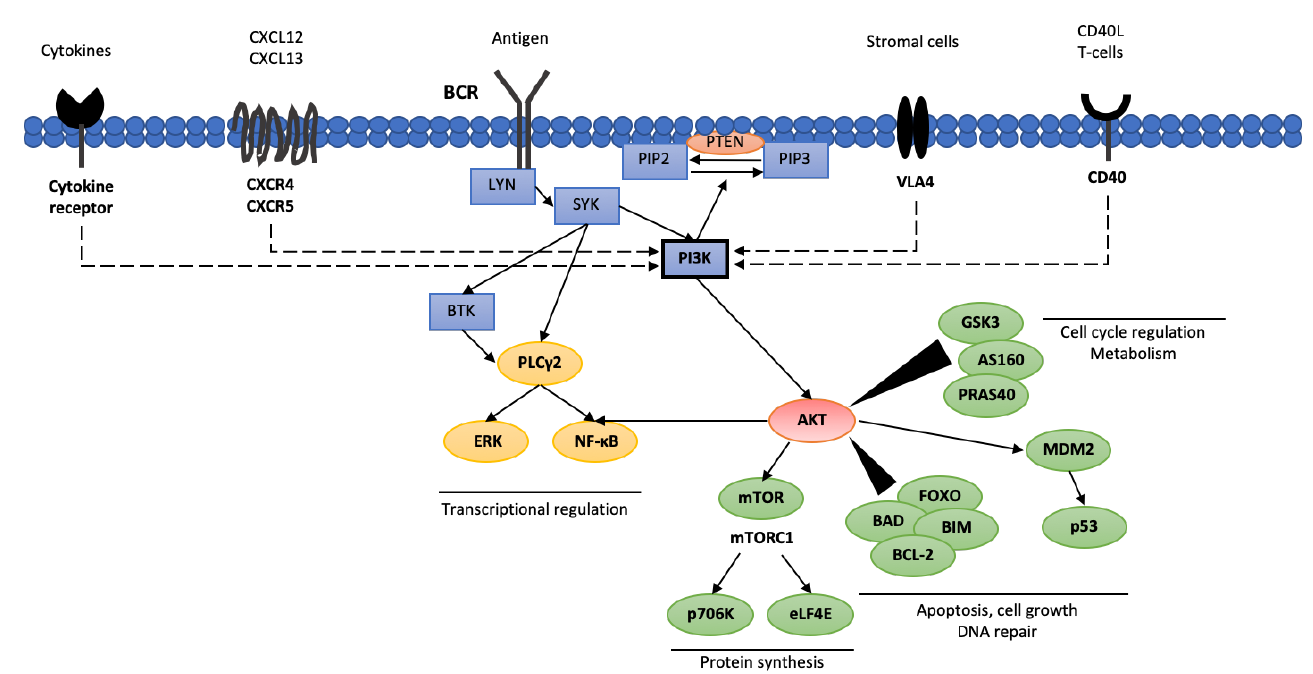
Figure 1. Phosphoinositide 3-kinases interacting pathways in CLL cells. AKT — protein kinase